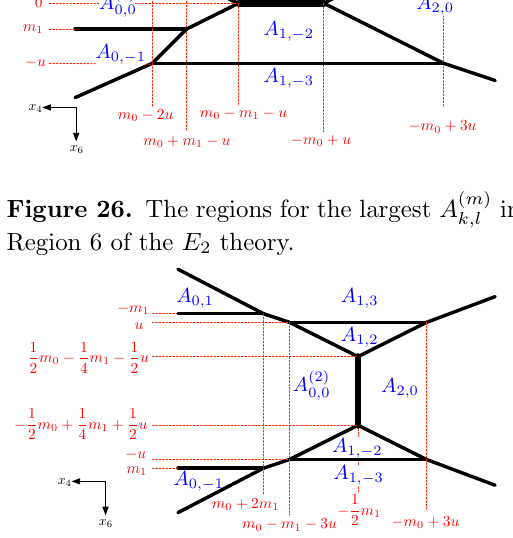
Figure 27. The regions for the largest A ( m ) Region 7 of the E 2 theory.